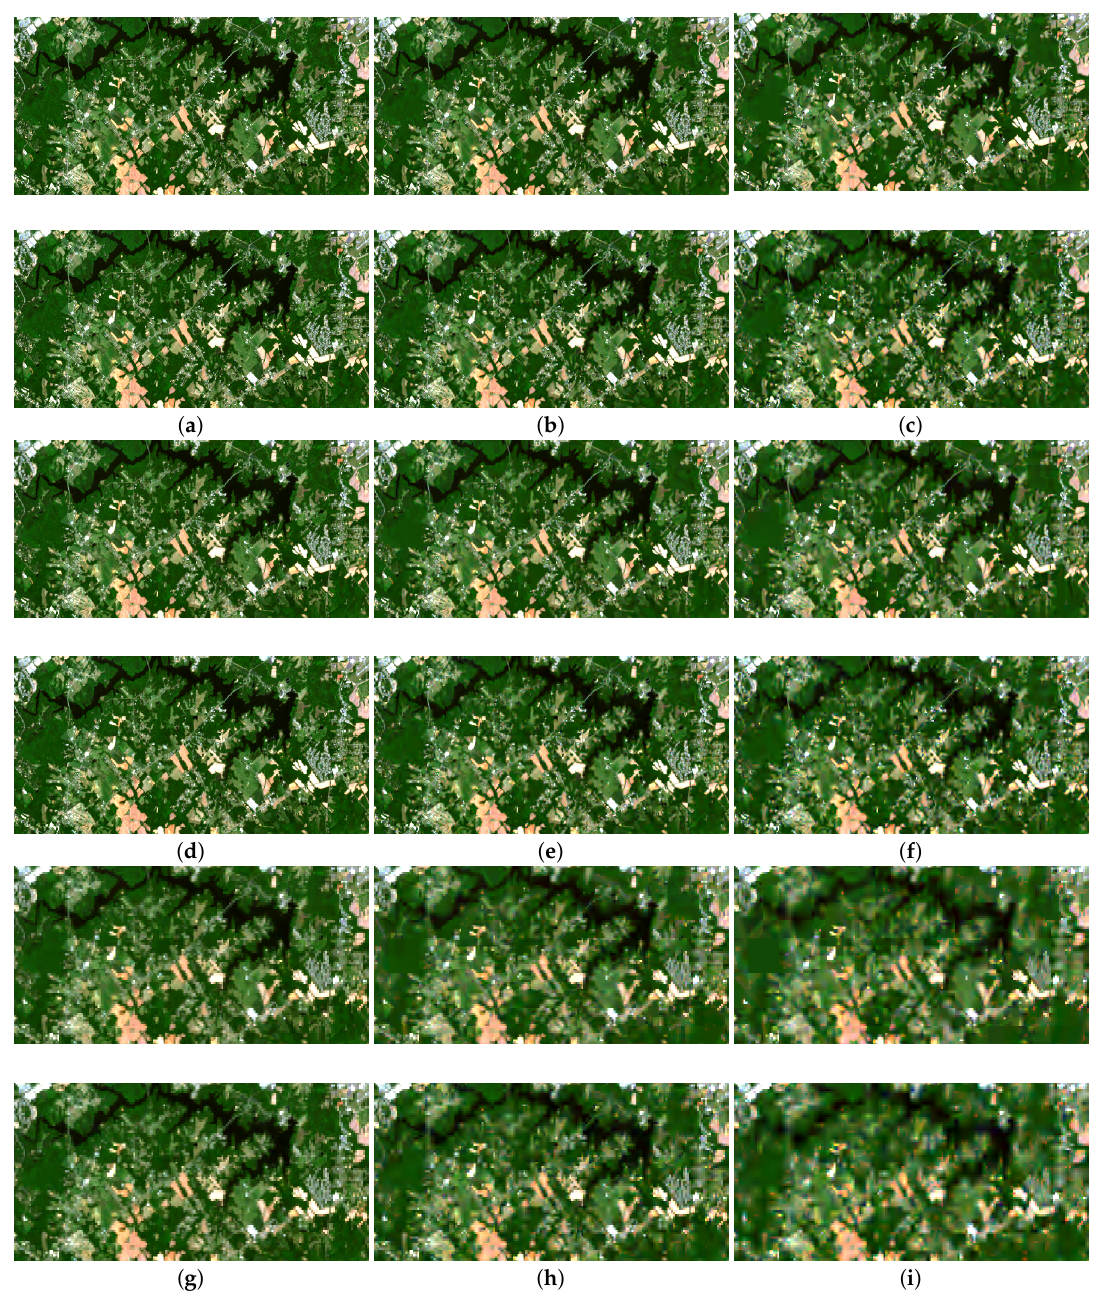
Figure 8. Visual comparison of HEVC and JPEG 2000 at the same level of PSNR. The first column corresponds to Sentinel 2 images of 10, 20, and 60 m generated at high PSNR of 70 [dB]. In the second column are images with 60 [dB], while in the last column are images with approximate lower borderline quality of 56 [dB]. Each pair of rows (3 in total) represents satellite images at exclusively one of the following spatial resolutions: 10 m ( a – c ), 20 m ( d – f ), and 60 m ( g – i ), respectively. The first row in each pair corresponds to obtained HEVC results, e.g., the first row of ( a – c ), while the second row in each pair is reserved for JPEG 2000 results with the same level of PSNR and spatial resolution (e.g., 10 m for ( a – c )). Presented image detail was taken from the test scene N o 7 in Table 1, Figure